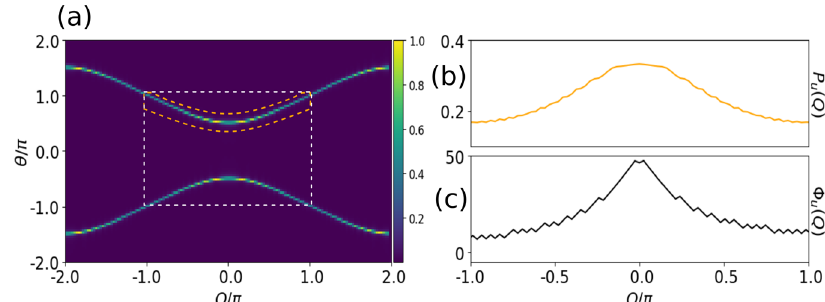
Fig. 7 Principle of measurement of the spectral power and of the spectral phase of the Floquet – Bloch eigenmodes. a Fourier power spectrum ~ U ð Q ; θ Þj 2 of the impulse response of the Floquet – Bloch lattice for the symmetric U loop. The vertical color bar in ( a ) indicates the mapping from the normalized spectral power j ~ U ð Q ; θ Þj 2 to colors. The spectral power of the Floquet – Bloch eigenmodes shown in ( b ) is determined by integrating the spectral power density between the orange dashed lines for each value of Q by using Eq. (6). The spectral phase shown in ( c ) is the argument ϕ U ( Q ) of the Fourier modes at the frequencies where the spectral power density is